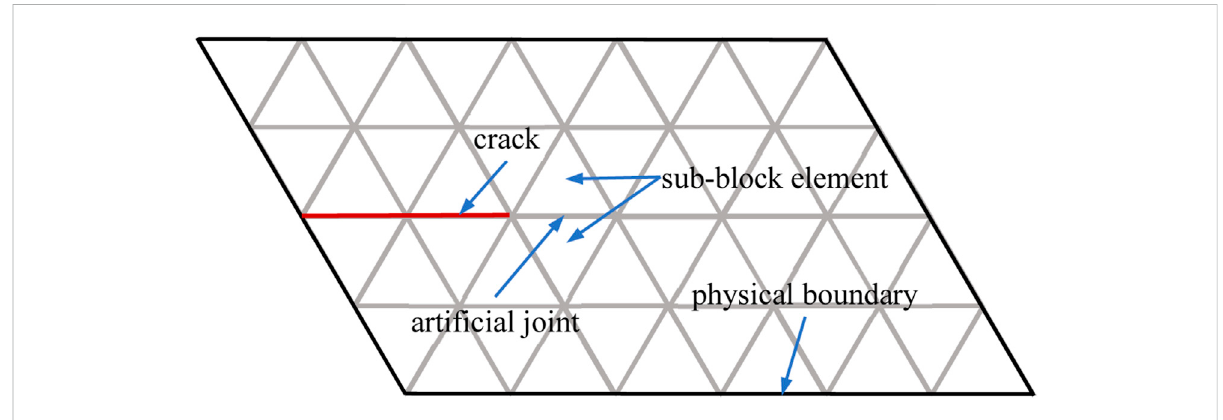
FIGURE 1 Illustration of the sub-block element DDA fracturing simulation